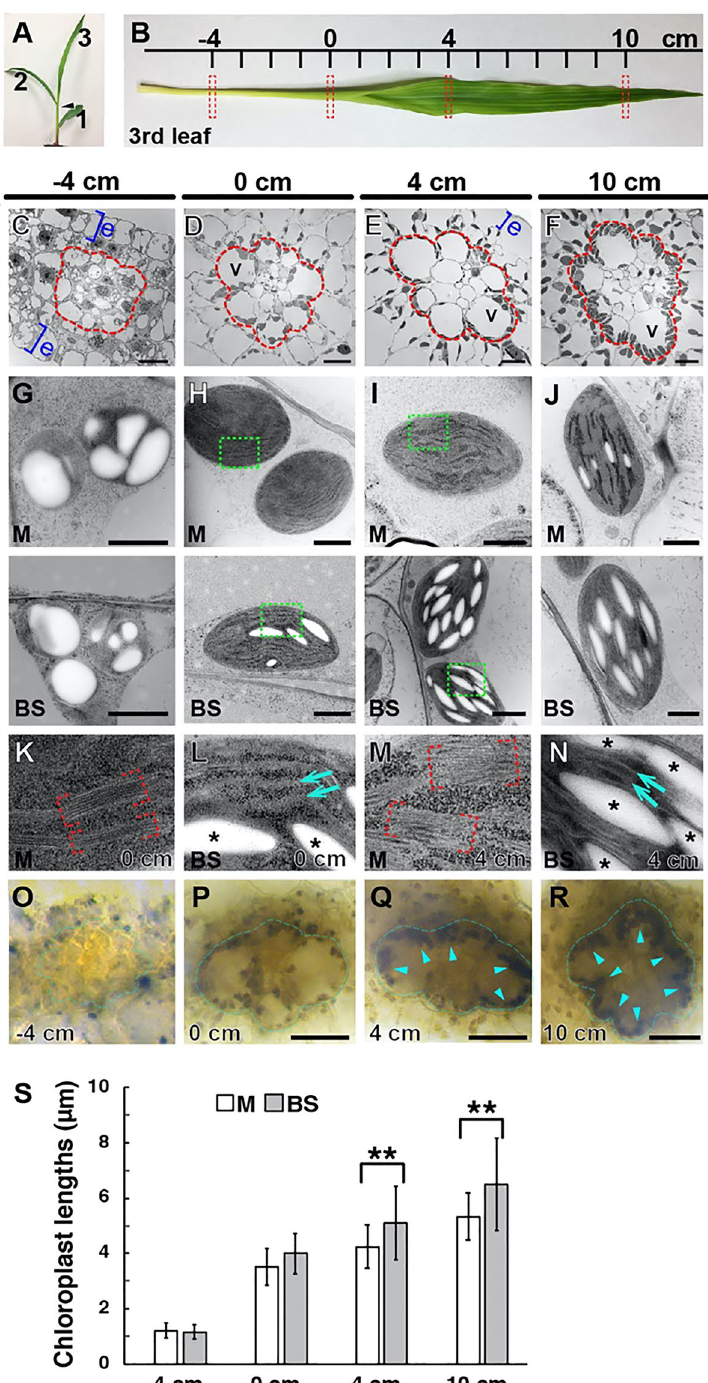
Figure 1. Dimorphic chloroplasts in the B73 seedling leaf. (A) A 9-day old maize B73 seedling. The first (1), second (2), and third (3) leaves are marked. (B) The four positions (−4, 0, 4, 10 cm) of the third leaf were isolated for microscopy analysis (dashed rectangles). (C–F) Low-magnification TEM images of the four segments in ( B ). The vascular bundle and BS cells are enclosed in the red outline in each panel. Blue brackets indicate epidermis (e) layers. V vacuole. Scale bars: 10 µm. (G–J) TEM photos of chloroplasts in M cells (upper row) and BS cells (lower row) in the four locations along the leaf. Scale bars: 1.0 µm. (K–N) Higher magnification micrographs of the boxed areas in (H) and (I) to show grana stacks in M chloroplasts (red brackets in K and M ) and stroma lamellae in BS chloroplasts (arrows in L and N ). Starch particles are denoted with asterisks. (O–R) Starch granules after iodine staining. Starch accumulation in BS cells (outlined with blue lines) is discerned in the 4- and 10-cm samples (blue arrowheads). Scale bars: 50 µm. (S) Lengths of M (white bars) and BS (grey bars) chloroplasts in TEM micrographs. Longer axes of chloroplasts (n = ~ 25 for each stage) were measured. Error bars correspond to standard deviations (SD) ( ** , p < 0.01; Student’s